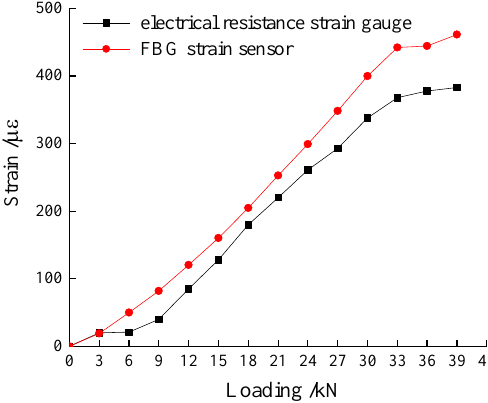
Figure 4. Comparison between FBG and electrical resistance strain gauge test results.